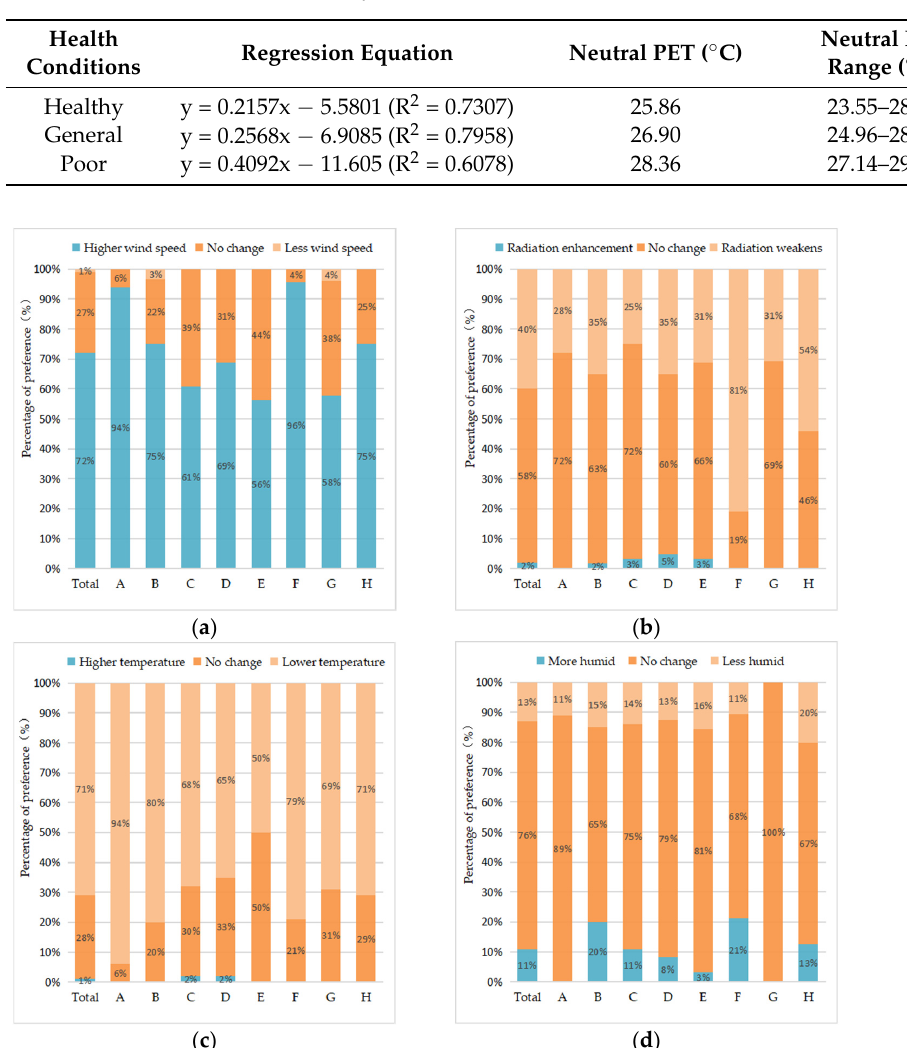
Figure 11. Preference votes for meteorological variables for the elderly. ( a ) wind speed; ( b ) solar radiation; ( c ) air temperature; ( d ) relative humidity.